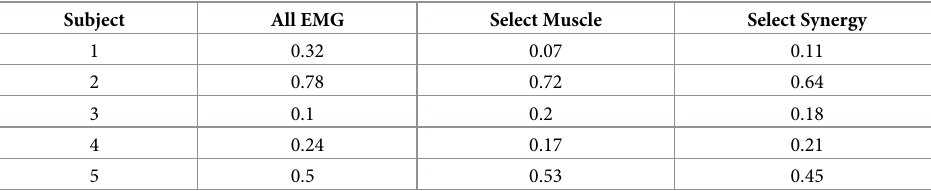
Table 2. Success rate of individual subjects for each condition.